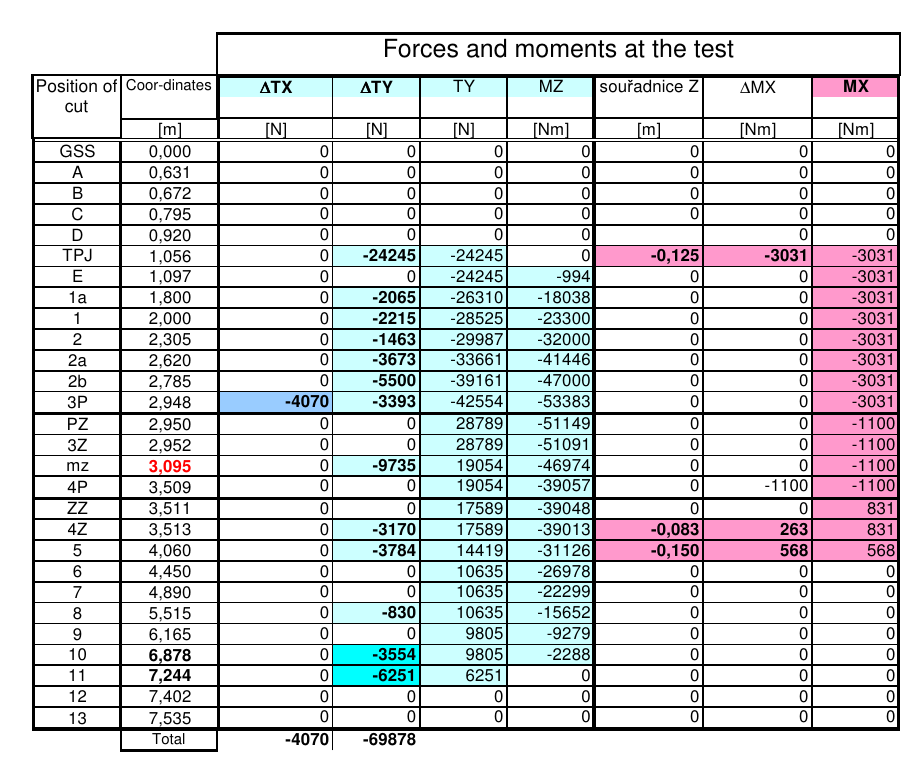
Table 2. Total load forces – case manoeuvre of vertical